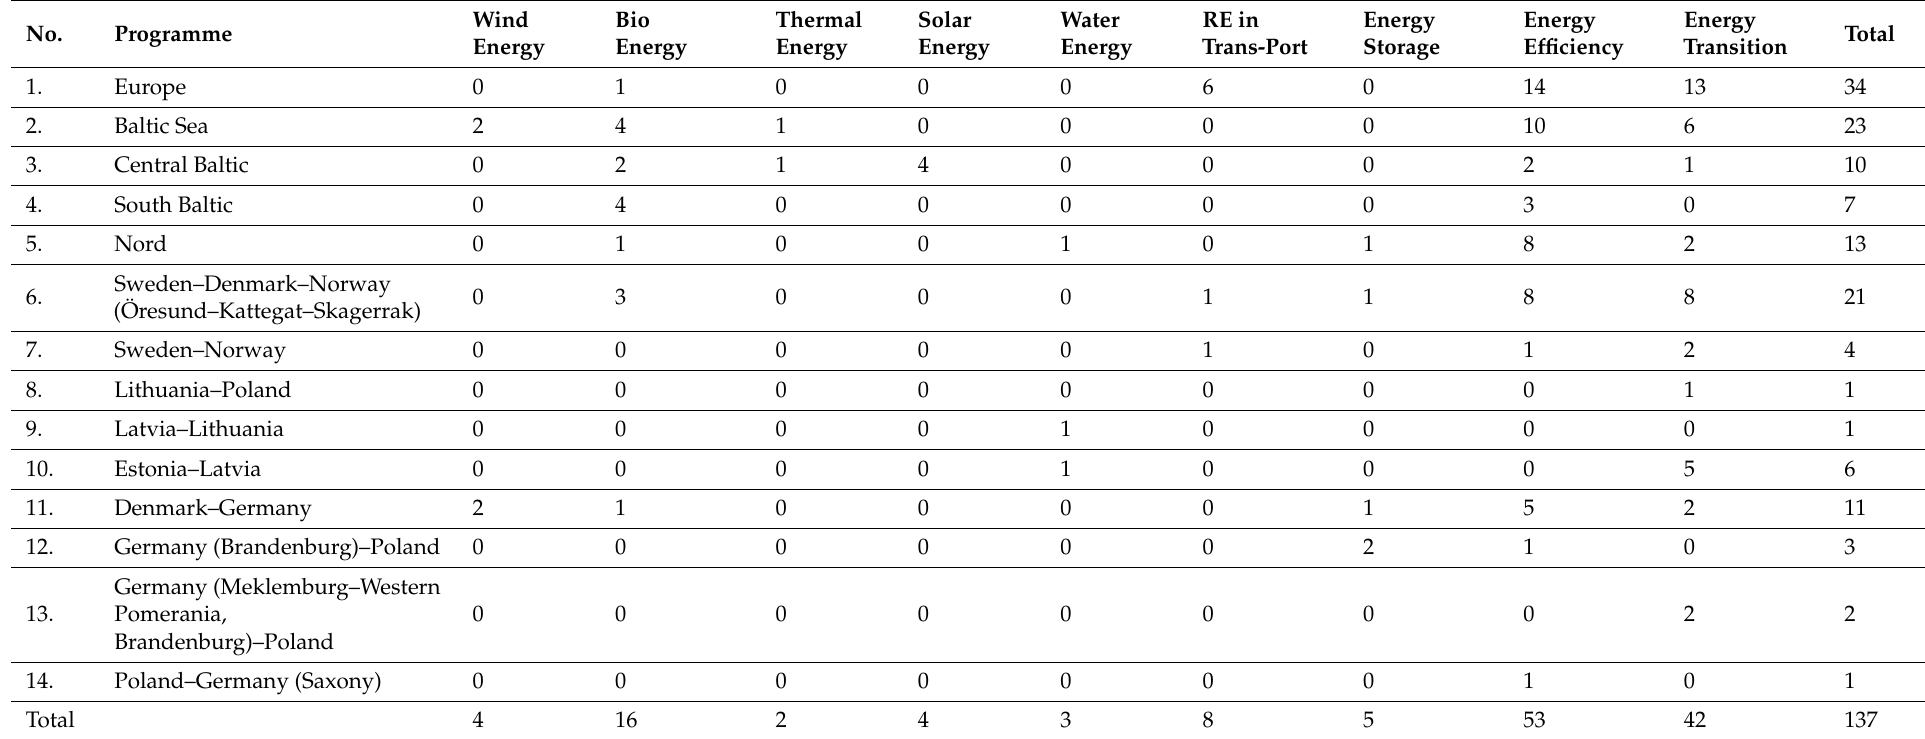
Table 5. Classification of energy transition projects according to subject range in